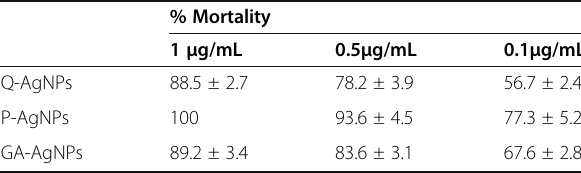
Table 4 In vitro cytotoxic activity of biosynthesized AgNPs